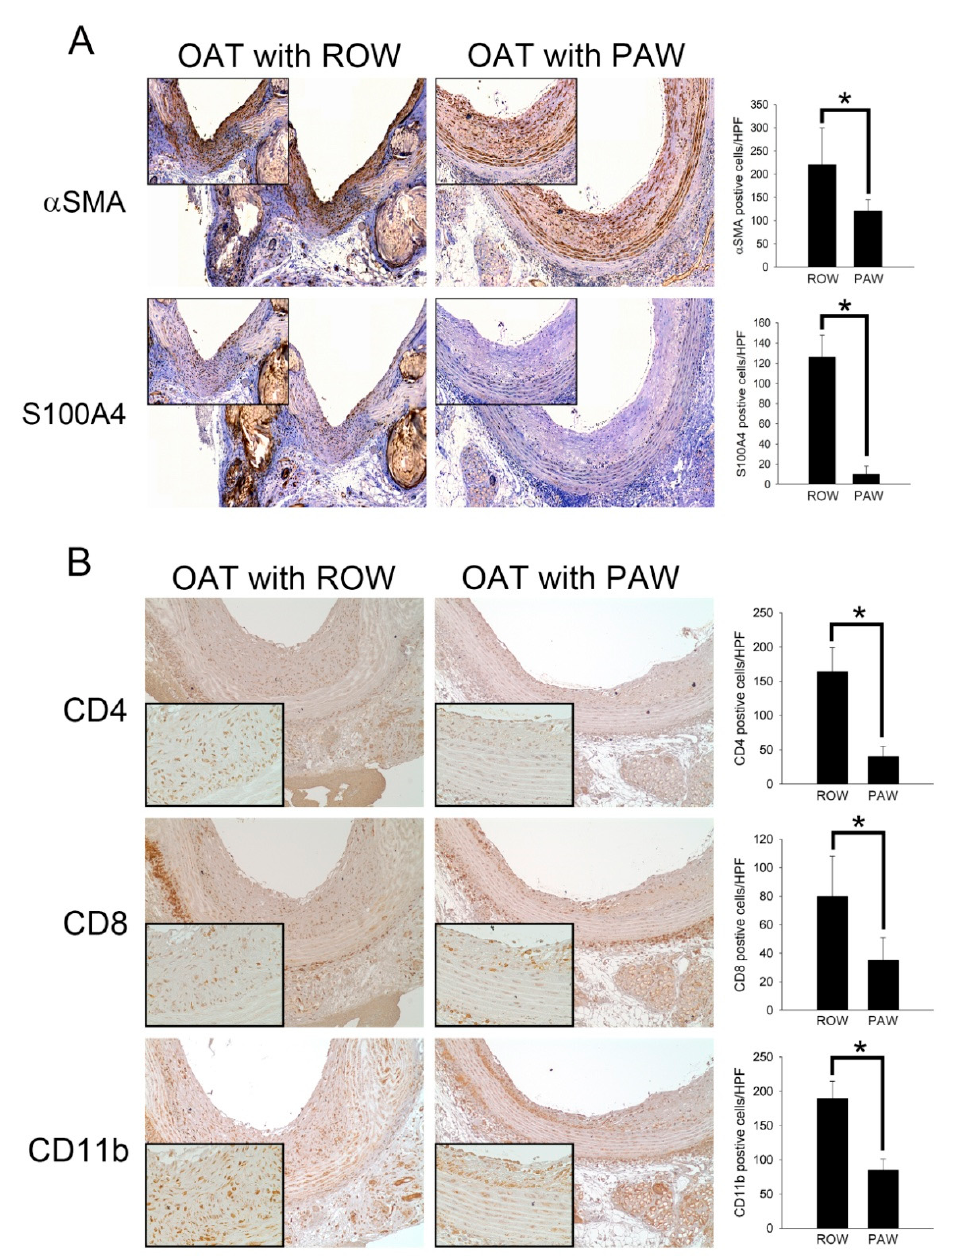
Figure 2. Administration of PAW is effective against SMCs, fibroblasts, CD4 + T lymphocytes, CD8 + T lymphocytes, and macrophage activity in OAT-induced chronic allograft vasculopathy. ( A ) Immunohistochemistry to assess proliferated SMCs ( α SMA) and accumulated fibroblasts (S100A4) in rat thoracic aortas from donor PVG/Seac rats. The lumen is uppermost in all sections; the images are 200 × magnified. Similar regions are shown as enlarged images (400 × magnification) in the upper left corners. The brown signal indicates α SMA- and S100A4-positivecells. ( B ) Immunohistochemistry to analyze accumulated helper T cells (CD4), cytotoxic T cells (CD8), and infiltrated macrophages (CD11b) in rat thoracic aortas from donor PVG/Seac rats. The images are 200 × magnified. Similar regions are shown as enlarged images (400 × magnification) in the lower left corners. The brown signal indicates CD4-, CD8- and CD11b-positive cells. Semi-quantification of immunohistochemically positive stained cells in high power field (HPF) is shown in the right panel of ( A , B ). The graphs represent the accumulation of cells in the aortas of rats from the experimental groups. The results are expressed as the mean ± SD. Statistical evaluations were performed using Student t -test, followed by Dunnett’s test. * p < 0.05 was considered as